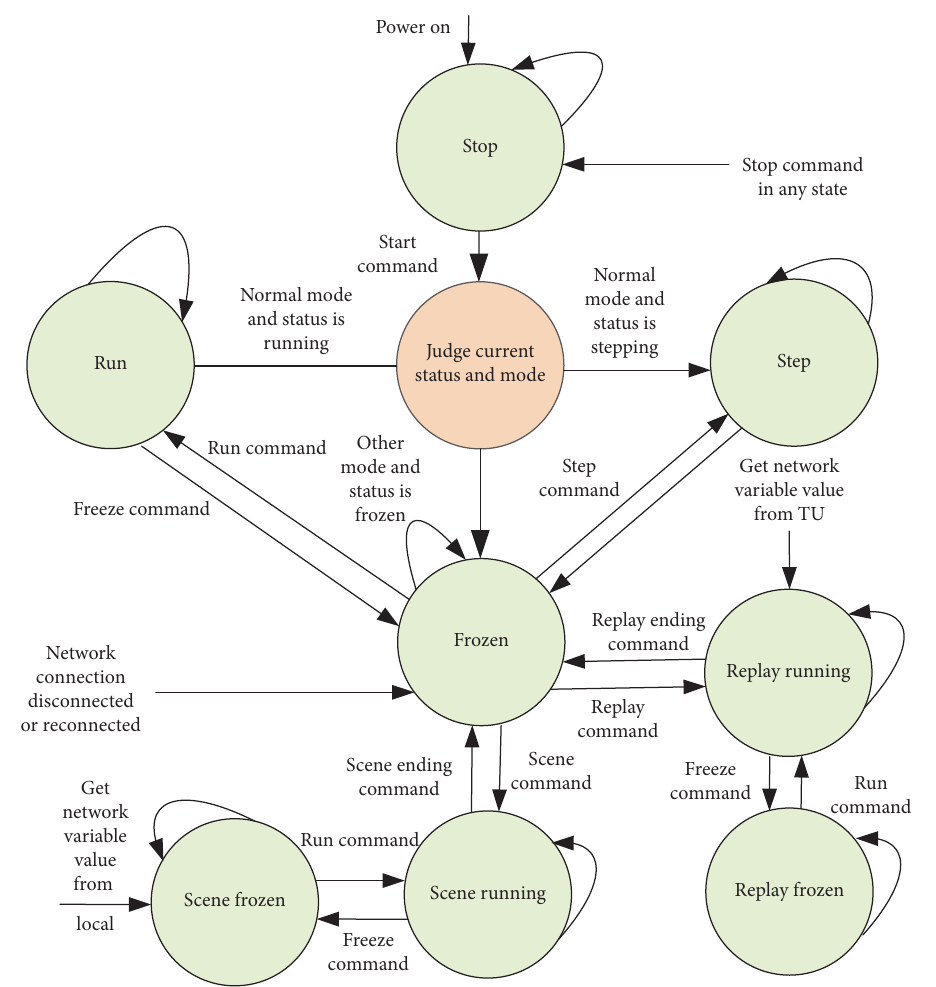
Figure 9: State switching diagram of simulation process.